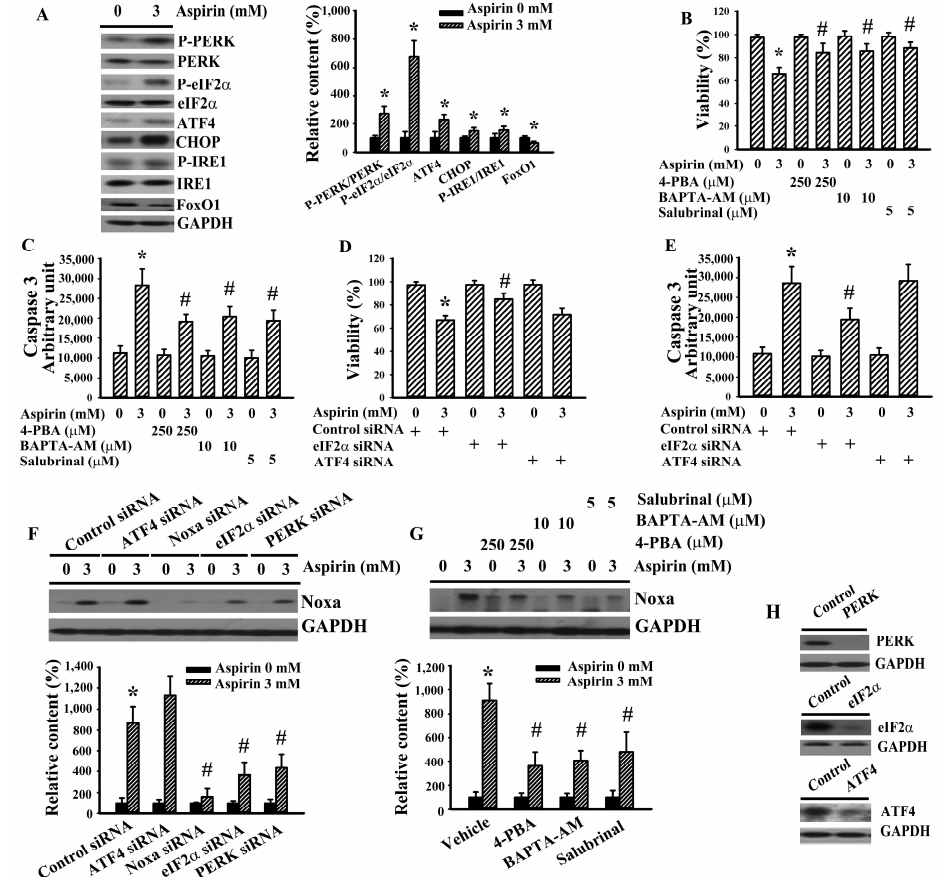
Figure 4. ER stress was crucial to aspirin-induced Noxa expression and apoptosis in H4 cells. ( A )